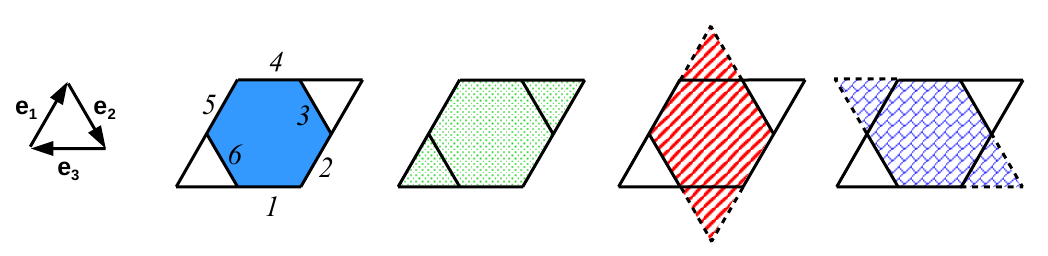
Figure 7: Kagome lattice unit cell with independent bonds enumerated from one to six (left). We consider four different plaquette terms: the elementary hexagon (marked in blue), as well as the three diamond shaped loops of length 8 (marked by green dots, red stripes and blue